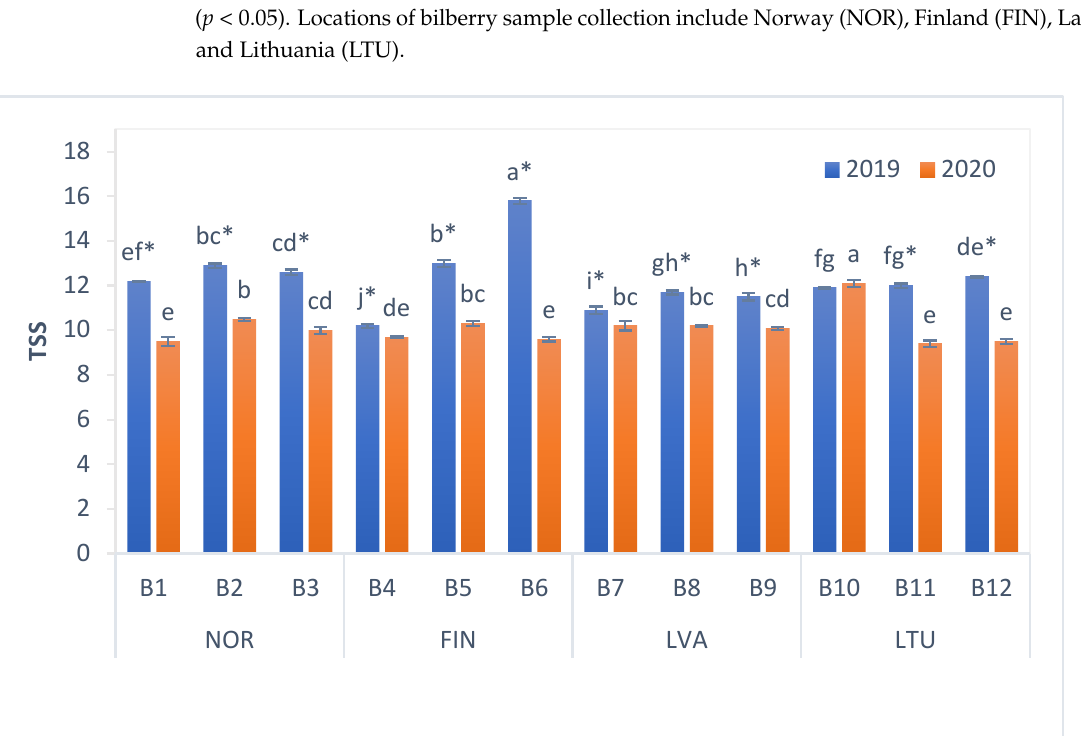
Figure 2. TSS values of bilberries. Values are presented as means ± standard deviations. Different letters within the same column indicate significant differences between the collection locations (B1–B12) ( p < 0.05). Significant differences between 2019 and 2020 are indicated by asterisks (*) ( p < 0.05). Locations of bilberry sample collection include Norway (NOR), Finland (FIN), Latvia (LVA) and Lithuania